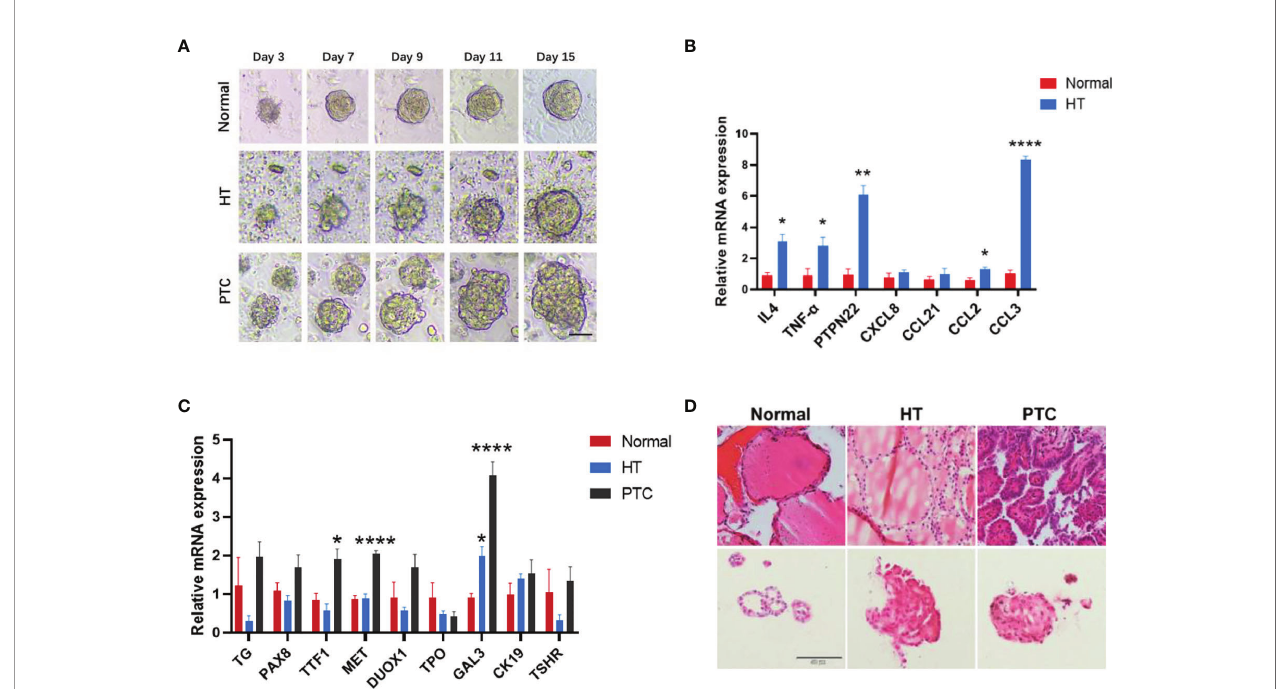
FIGURE 4 | Organoid cultures derived from patients with Hashimoto ’ s thyroiditis (HT) and papillary thyroid carcinoma (PTC). (A) Time-lapse imaging sequence of Control, HT, and PTC organoids. Scale bar, 100 m m. (B) Quantitative PCR (qPCR) analysis of the HT and chemokine characterization marker mRNA level in thyroid organoids (Normal, n=4; HT, n=4). (C) qPCR analysis of the HT characterization marker mRNA level in thyroid organoids (Normal, n=3; HT, n=5; PTC, n=6). All data are presented as mean±SEM. (D) H&E staining of the organoids and their corresponding tissues, respectively. Scale bar, 50 m m. Error bars show the mean±SEM. * P <0.05; ** P <0.01; **** P